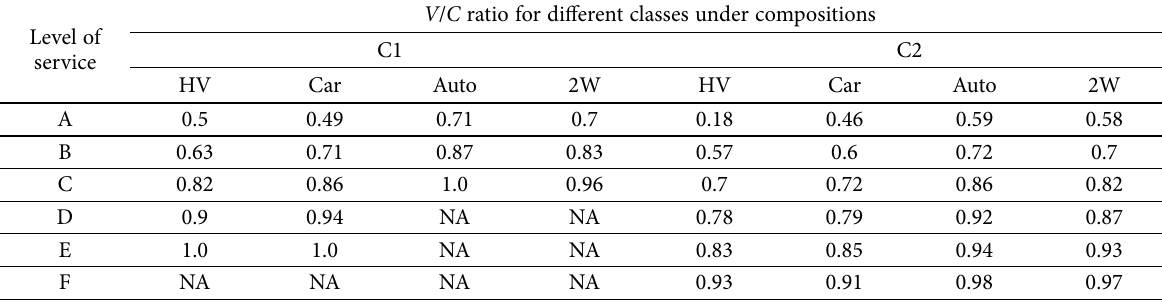
Table 4. V / C ratios at different levels of service